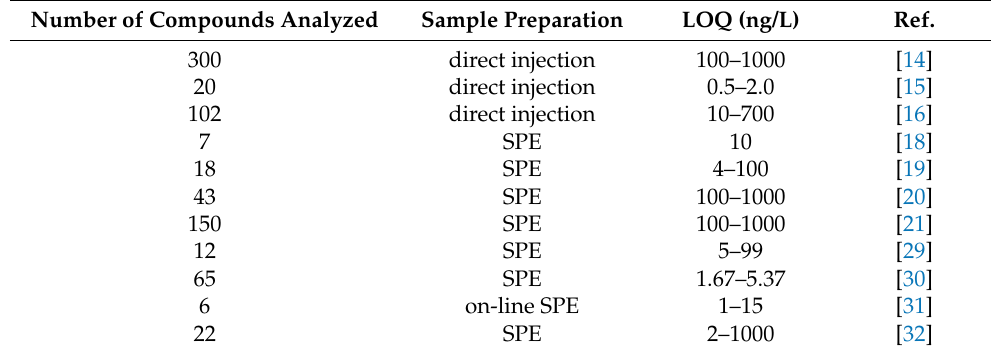
Table 3. Examples for methods using only LC-MS for pesticide analysis in